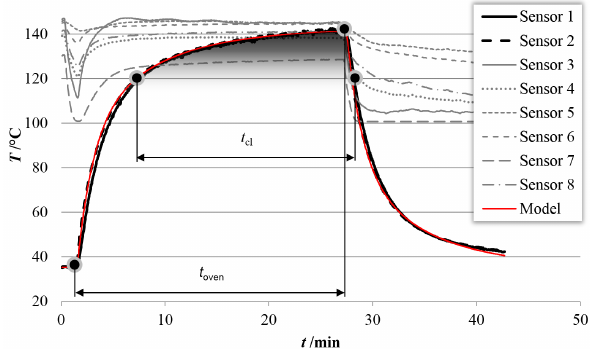
Figure 10. Temperature profile during the cross-linking process.